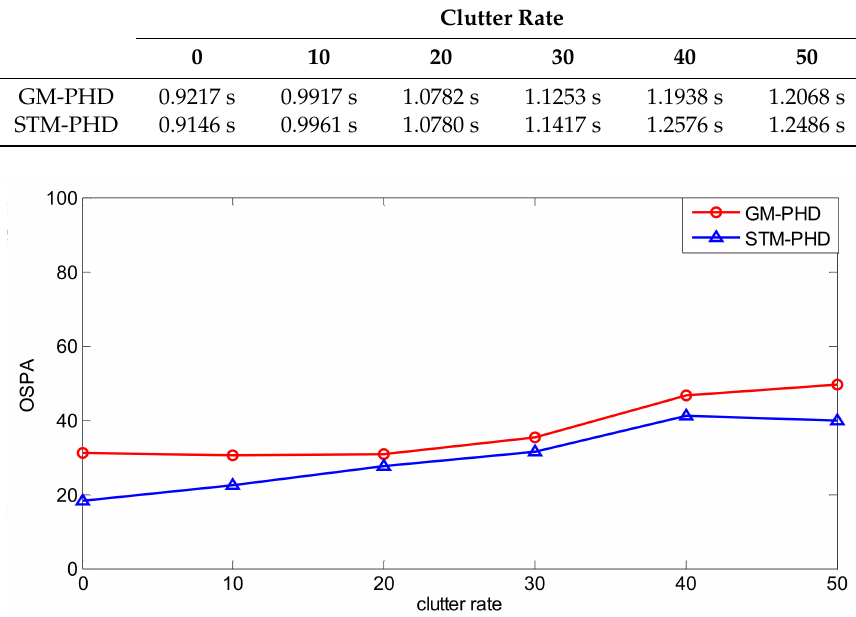
Table 2. Average computing time with different clutter rates.